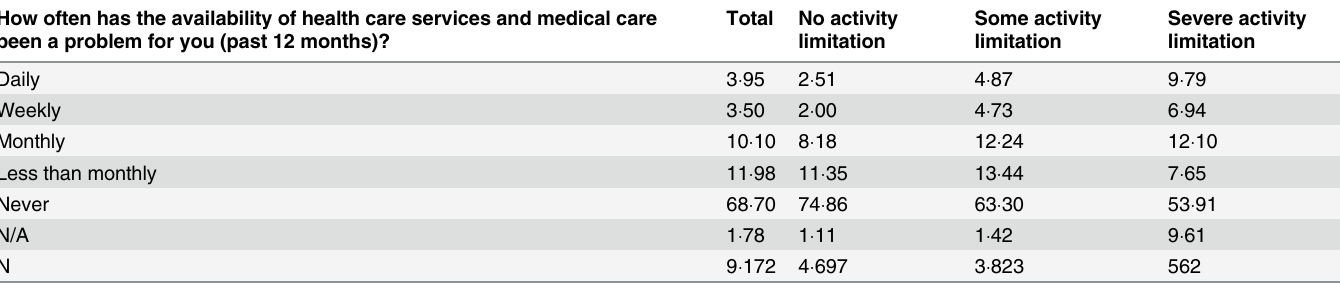
Table 2. Availability of health care services a problem, by activity limitation